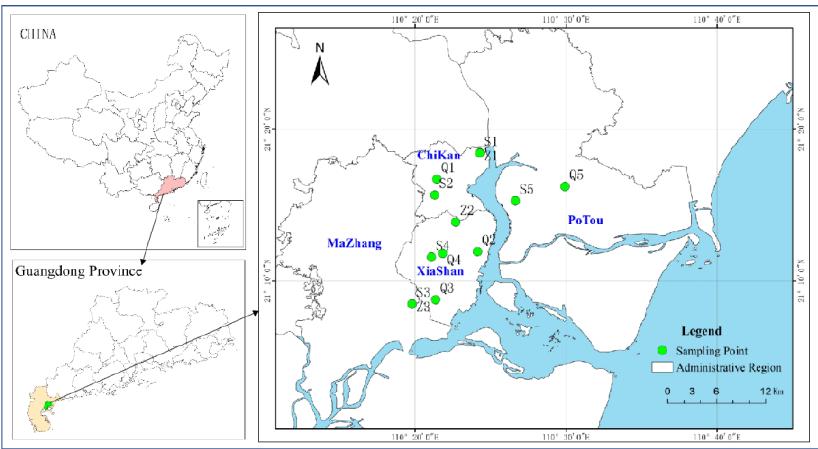
Figure 1. Location of the sampling sites.